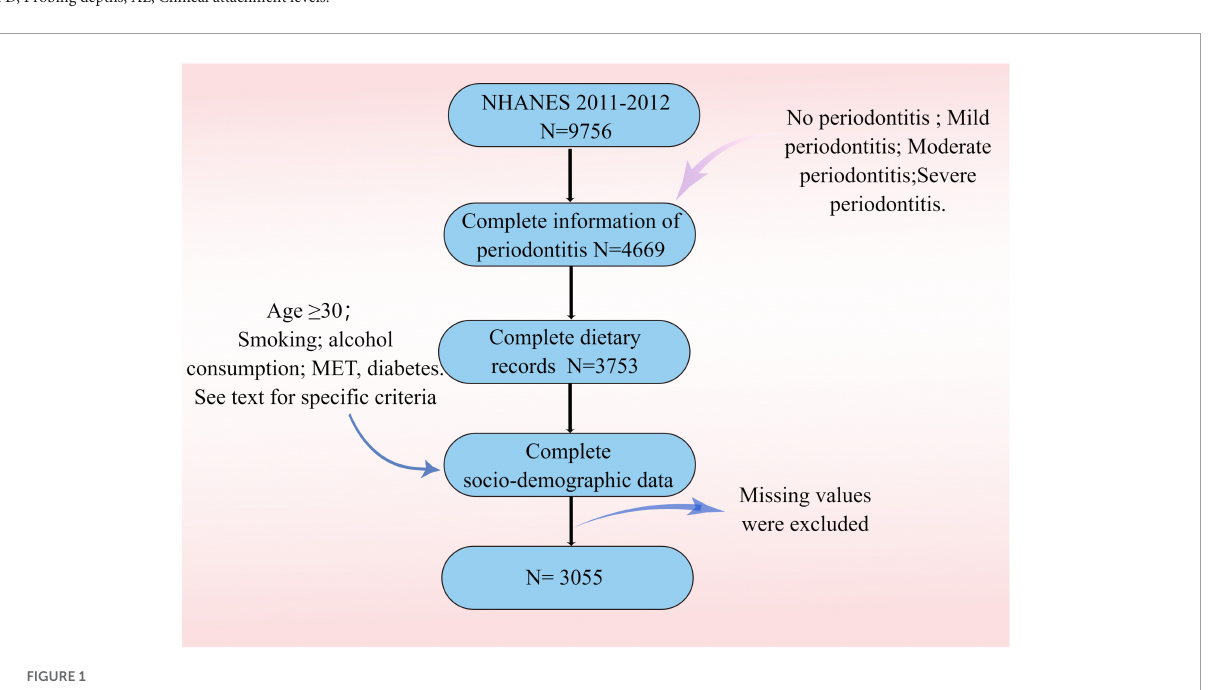
FIGURE1 Flowchart of the study